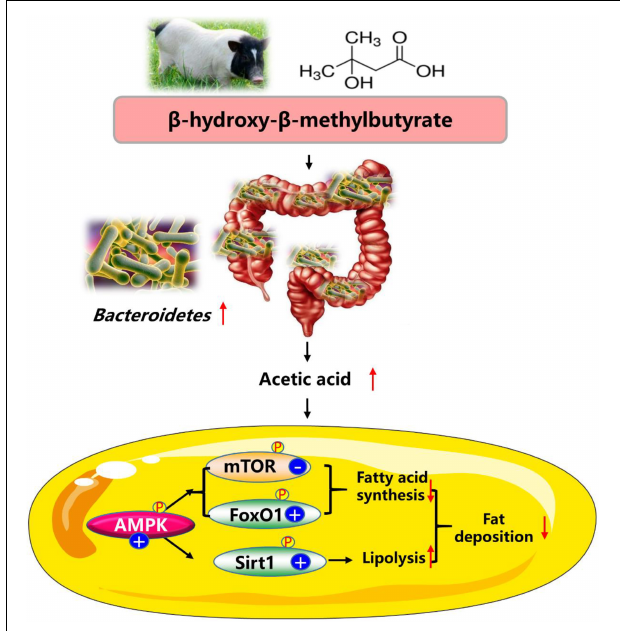
FIGURE 7 | Proposed mechanisms of dietary HMB supplementation for modulating the lipid metabolism in adipose tissue of Bama Xiang mini-pigs. AMPK, AMP-activated protein kinase; FoxO1, forkhead box O1; mTOR, mammalian target of rapamycin; Sirt1, silent information regulator 2 related enzyme